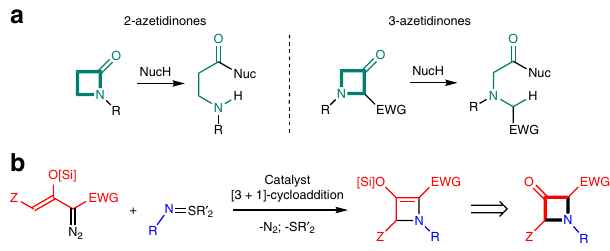
Fig. 1 Strain-induced ring opening of azetidinones and [3 + 1]-cycloaddition. a Amide ring opening of 2-azetidinones compared with retro-Claisen ring opening of EWG-activated 3-azetidinones. b Generation of 3-azetidinones via catalytic [3 + 1]-cycloaddition of silyl-protected enoldiazoacetates with imido sulfur